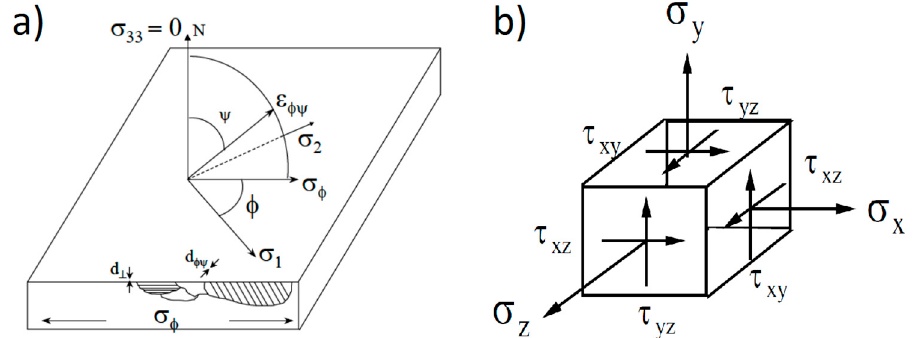
Figure 4. Angle and directions of stresses and unit strains in a flat sample ( a ), and stress tensor with the principal stresses schema ( b ) [13].